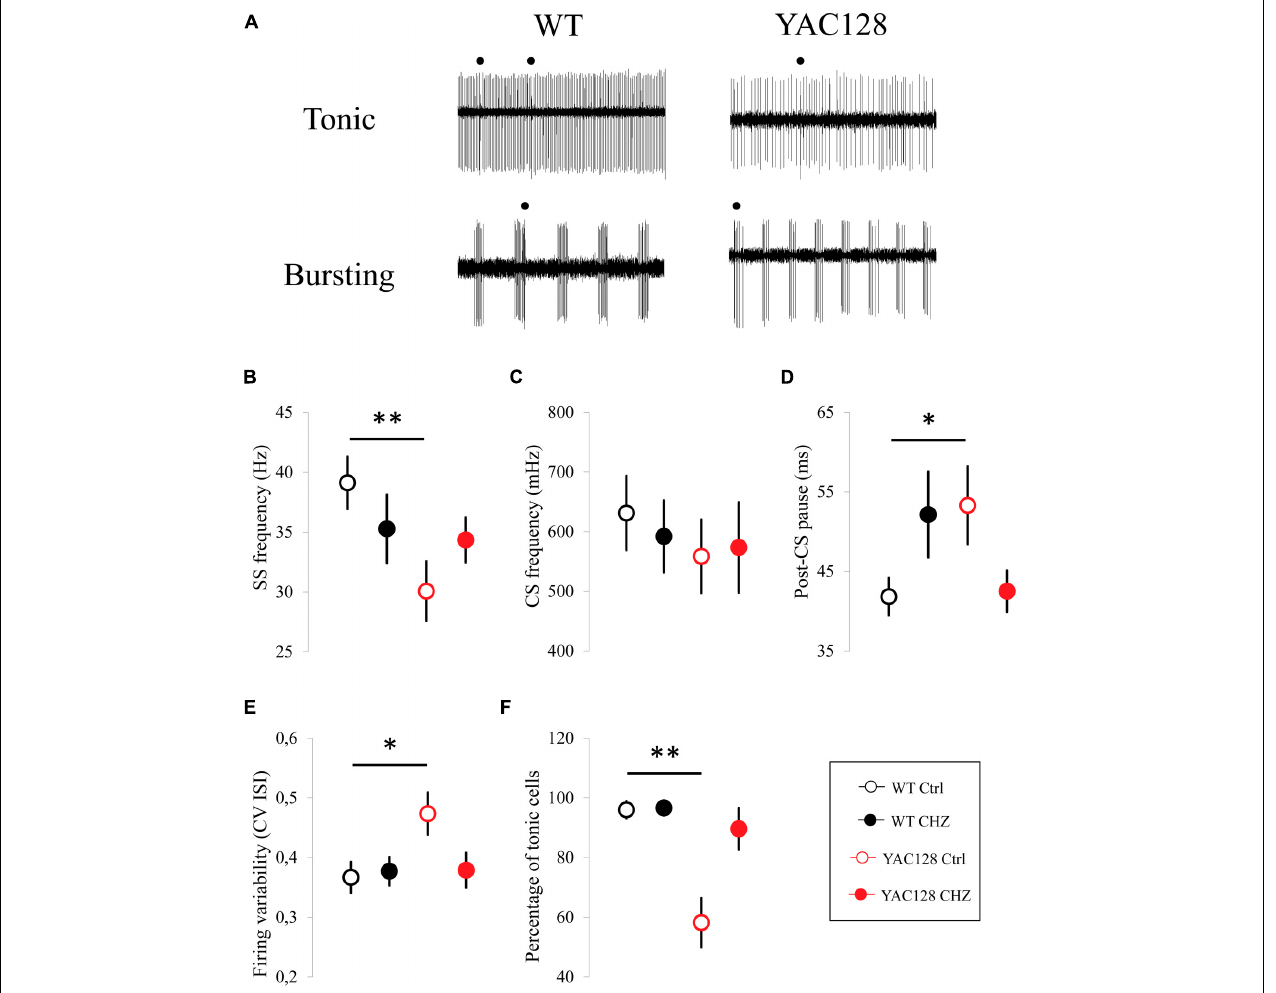
FIGURE 2 | Long-term injections of 30 mg/kg CHZ alleviate the age-dependent dysfunction in the firing pattern of 12-month-old HD PCs. (A) Examples of tonic and bursting PC activity in 12-month-old WT and YAC128 mice. Recording traces 3 s in duration are shown. Complex spikes are marked by filled circles. (B) The average SS firing frequency was significantly less in 12-month-old YAC128 mice compared to WT mice and was recovered after treatment with CHZ. ** p < 0.01. (C) No statistically significant difference was observed in CS firing frequency between all the experimental groups. (D) The average post-CS pause in PC discharge was significantly higher in 12-month-old YAC128 mice compared to WT mice and was recovered after treatment with CHZ. * p < 0.05. (E,F) CHZ injections recover the precision of the PC pacemaker activity in 12-month-old YAC128 HD mice. At 12 months of age, the systematic CHZ injections decreased the firing variability (E) and increased the proportion of tonically firing cells (F) in YAC128 HD mice. * p < 0.05, ** p < 0.01. For all the measured properties number of tonic cells (n) and number of animals (m) were following: n = 51 cells for WT mice in the control group (WT Ctrl), m = 7 WT Ctrl mice; n = 51 cells for WT mice injected with CHZ, m = 8 WT CHZ mice; n = 40 cells for YAC128 mice in the control group (YAC128 Ctrl), m = 11 YAC128 Ctrl mice; n = 34 cells for YAC128 mice injected with CHZ, m = 9 YAC128 CHZ mice.